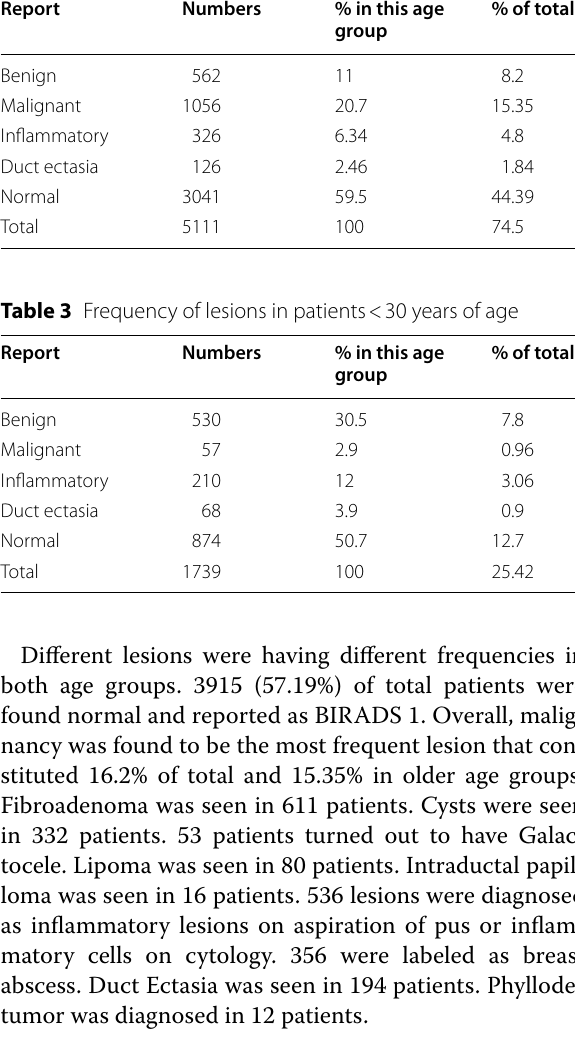
Table 2 Frequency of lesions in patients > 30 years of age Report